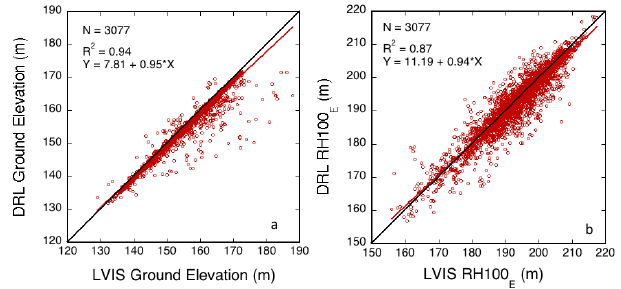
Fig. 1. Relationship between LVIS ground elevation and DRL ground elevation, and between LVIS top canopy elevation and DRL top canopy